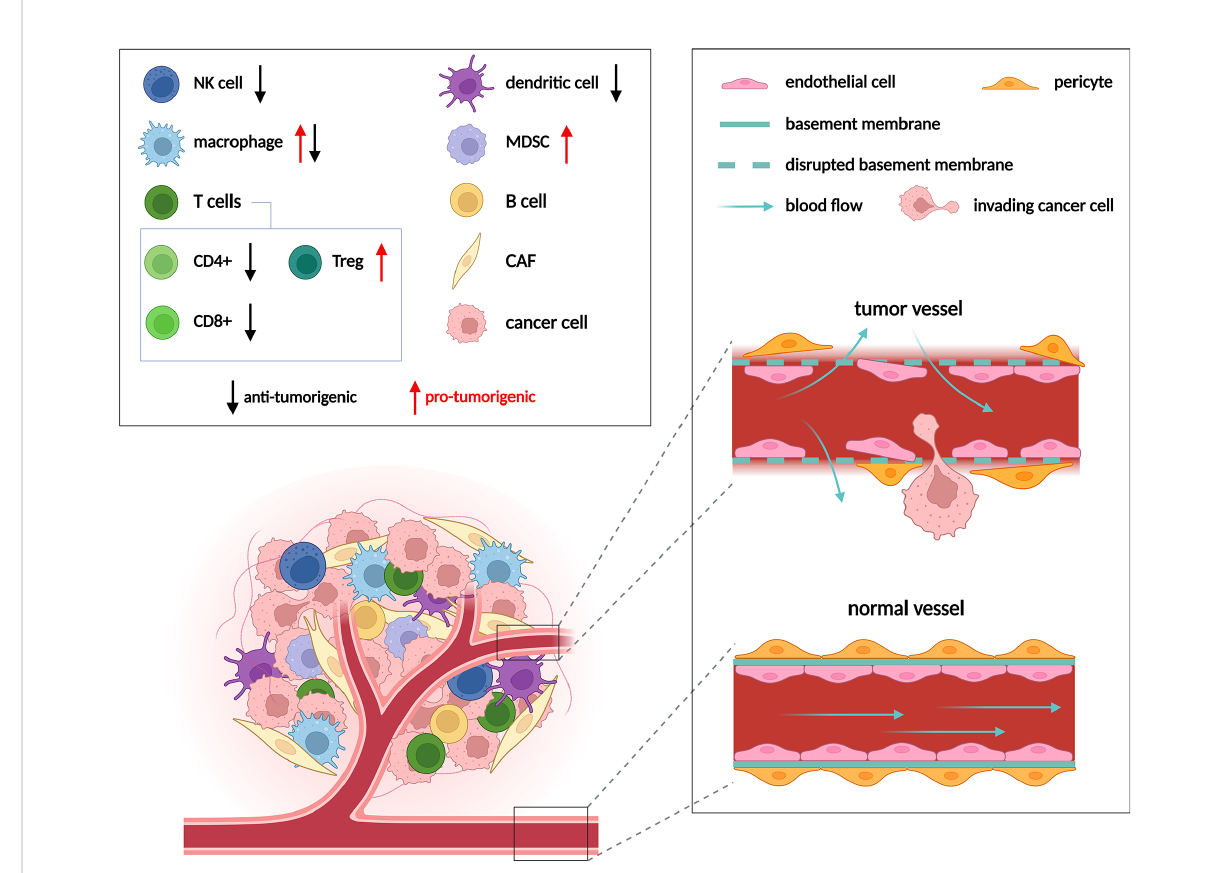
FIGURE 1 Cell populations in the TME and their role in tumor progression. Composition of the TME varies between different tumor types, but usually includes cancer cells, immune cells, cancer associated fi broblasts (CAFs) and endothelial cells (ECs). Multiple types of immune cells are present in the TME, only those mentioned in following fi gures are depicted. Immune cells can either promote (red arrows) or suppress (black arrows) tumor growth. ECs form the inner lining of blood vessels. Vessels are normally well ordered, covered by an intact basement membrane and a layer of pericytes. In the TME vessels become disorganized due to excessive pro-angiogenic signaling. Such abnormal vessels are leaky and become a gateway for tumor metastasis. Adapted from “ Tumor Microenvironment 2 ” , by BioRender.com (2022). Retrieved from https://app.